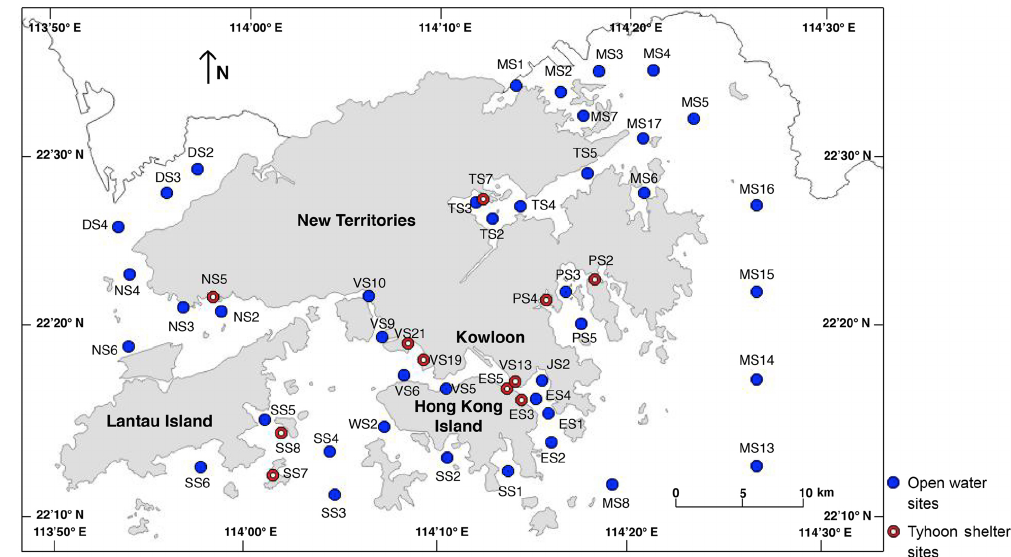
Figure 1. Locality map showing the 52 sampling sites across Hong Kong, including 41 open water sites (blue dots) and 11 typhoon shelter sites (red open dots). From west to east, DS: Deep Bay; NS: northwestern waters; SS: southern waters; VS: Victoria Harbour; ES: eastern buffer; JS: Junk Bay; TS: Tolo Harbour; PS: Port Shelter; MS: Mirs